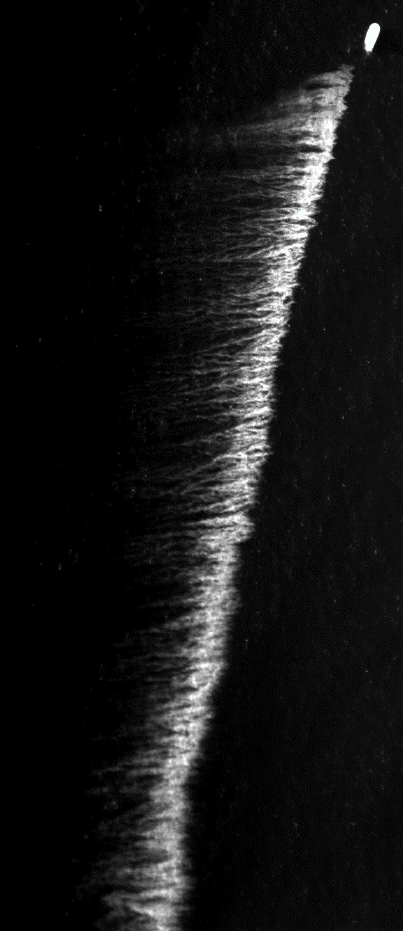
Figure 2. Visible high-resolution image of the Uranine dye plume in its early stage after the release. The dye boat in the upper right corner is ≈17 m long.